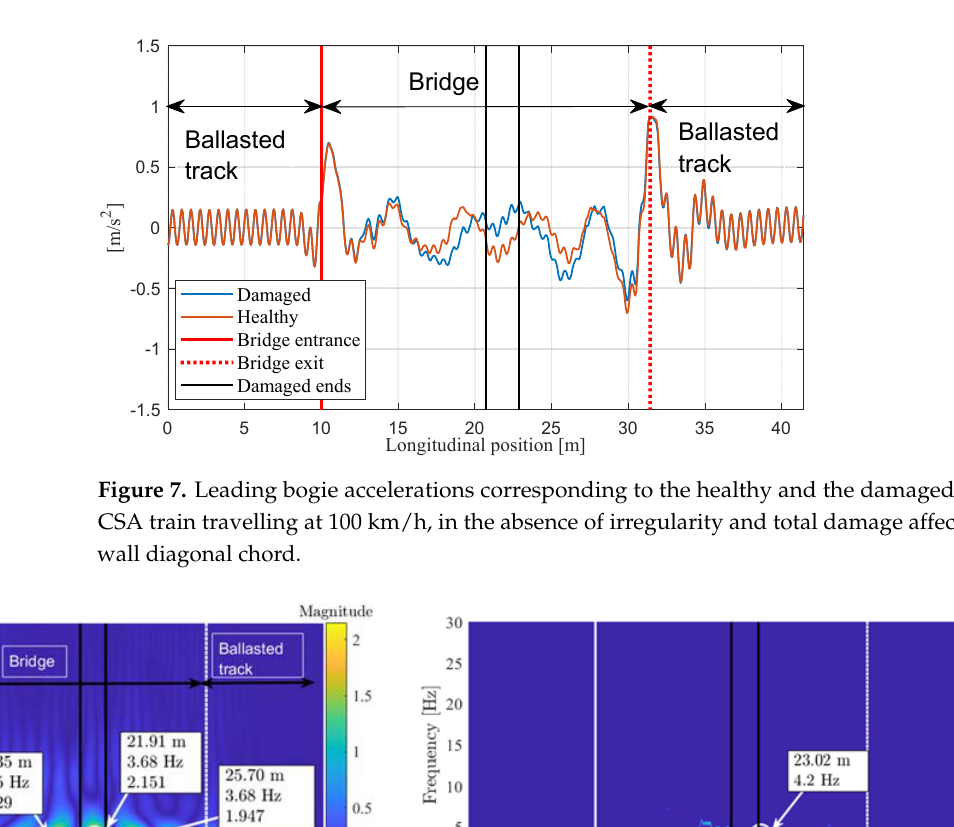
Figure 8. Damage detection results in the absence of track irregularity; the CSA train travels at 100 km/h and total damage on the fastening between the diagonal member and the lateral chord is considered ( a ) Module of the difference in wavelet coefficients. ( b ) Hilbert spectrum.